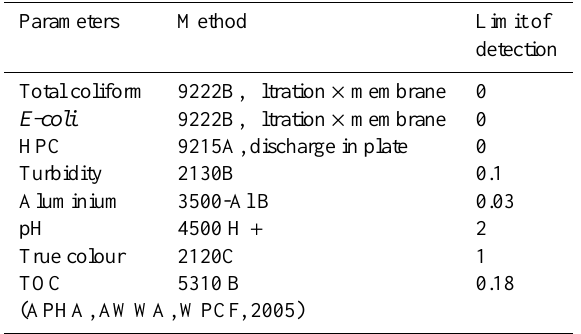
Table 5. Water quality parameters and analysis